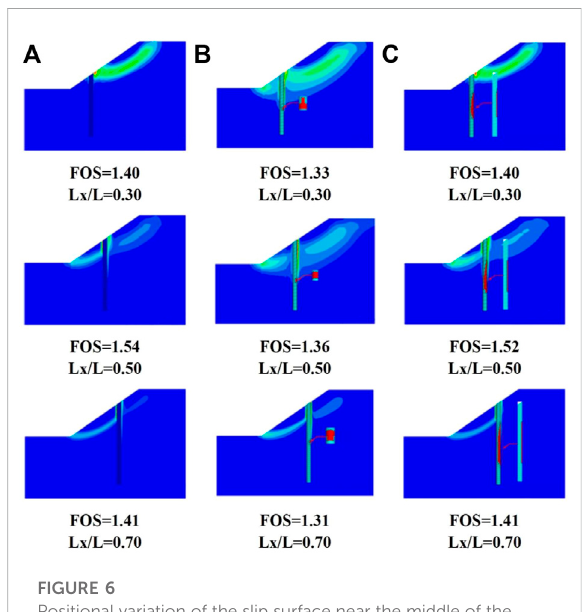
FIGURE 6 Positional variation of the slip surface near the middle of